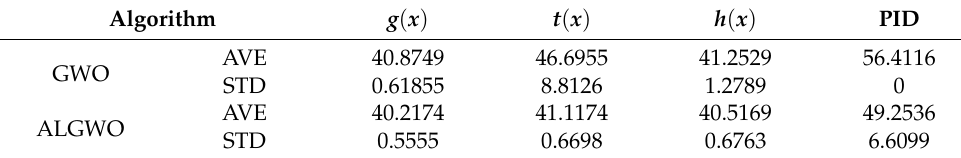
Table 10. The comparison of final fitness of algorithms on test system 6.